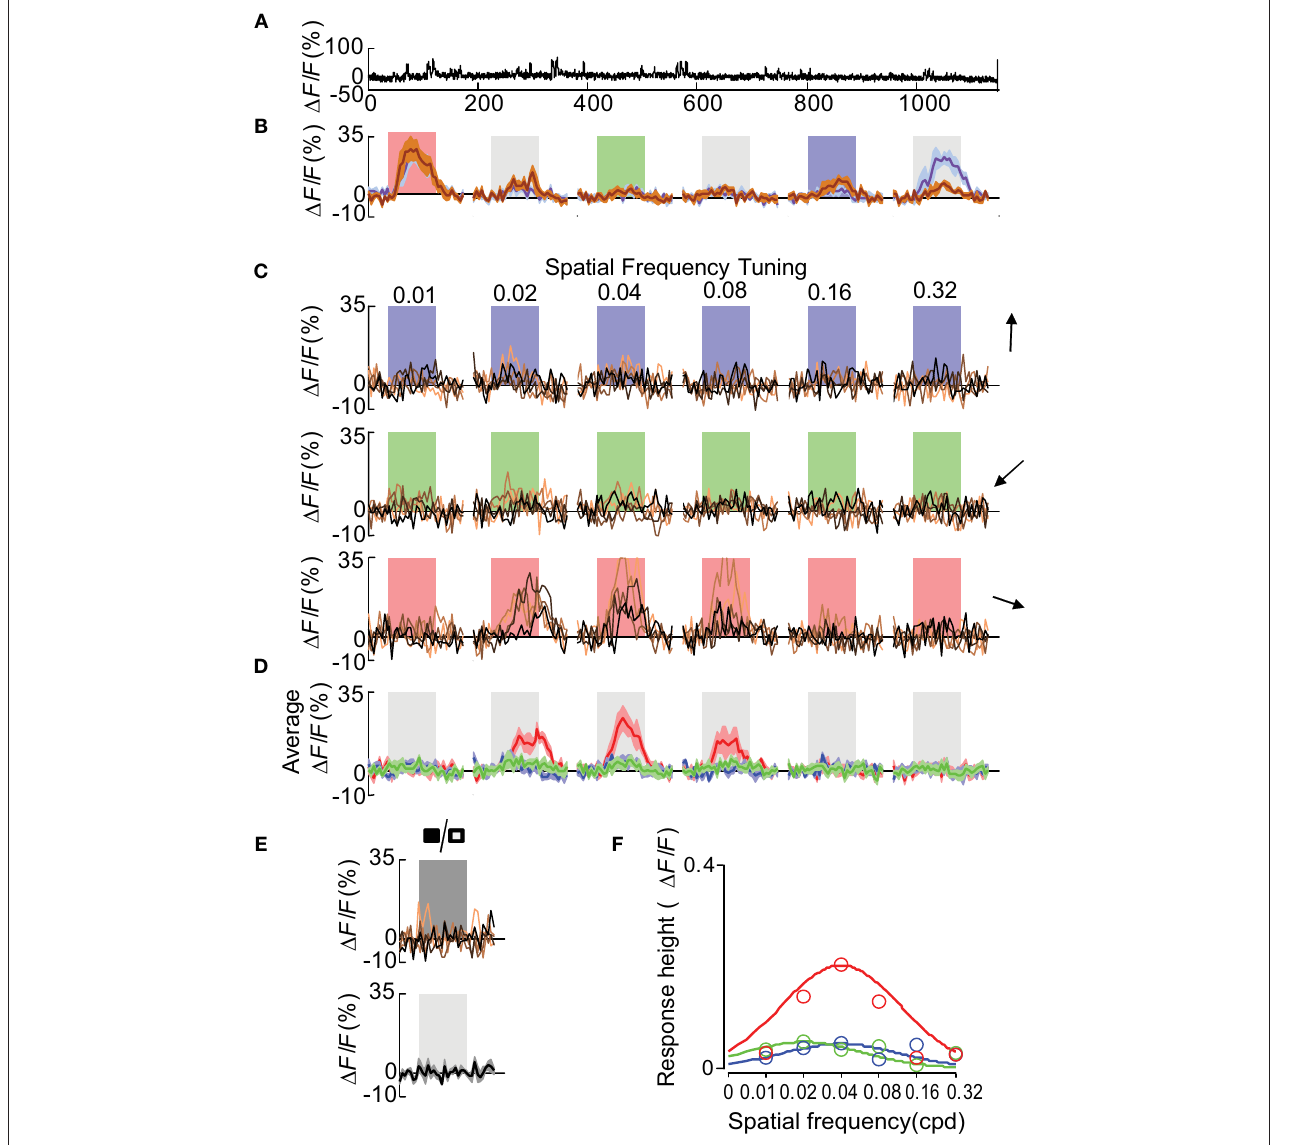
copper denotes temporal sequence of trials within that stimulus condition. (D) Average of the five presentations shown in [ (C) color coded by the background of the shaded area in (C) ]. Shaded area around the mean represent mean ± SEM ( n = 5). (e) Responses to five repetitions of full field light–dark flicker shown in upper row and average shown in lower row. Shaded area around the mean represent mean ± SEM ( n = 5). (F) Spatial frequency tuning of the cells to the three directions [colors as shown in (C,D) ]. A single Gaussian was fitted to the responses at various spatial frequencies for each direction. Preferred spatial frequency of the cell was 0.04